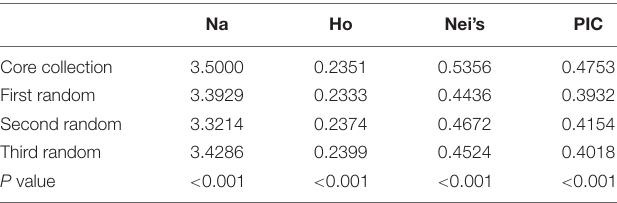
TABLE 3 | Differences between genetic diversity of core collection and pseudo-core